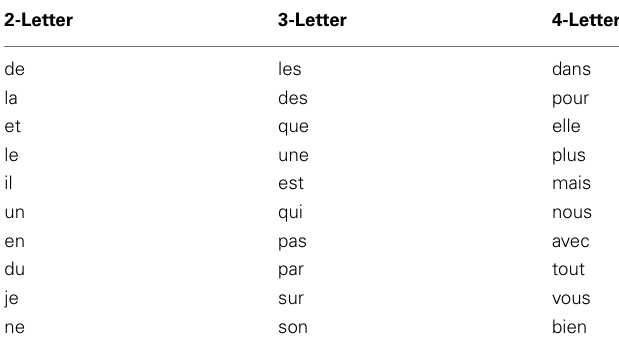
Table 1 | List of words (in